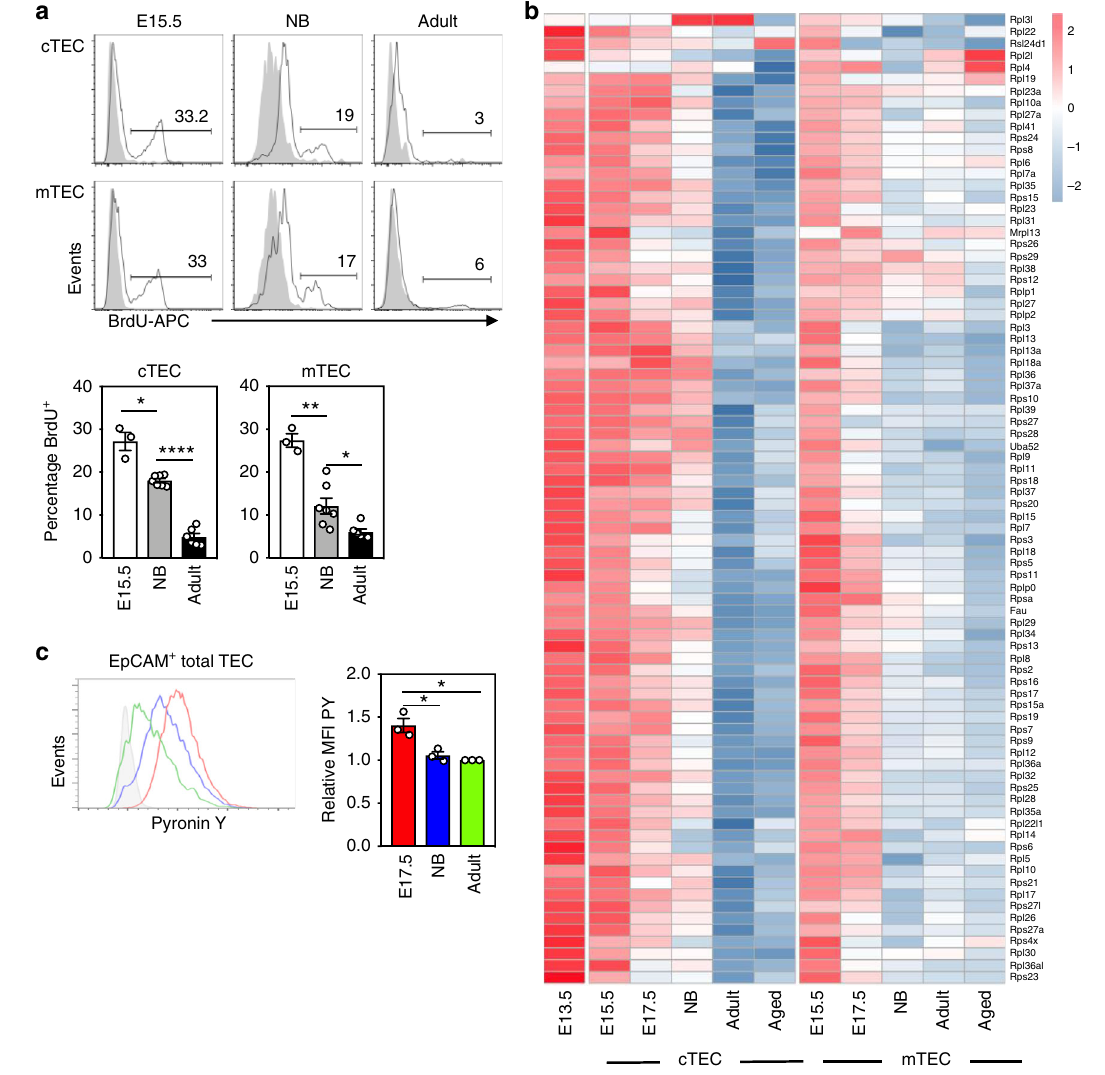
Fig. 2 TEC have reduced rates of proliferation and ribosomal biogenesis with age. a Representative fl ow plots of the frequency of BrdU + cells in cTEC (CD45 − EpCAM + Ly51 + UEA − ) (above) and mTEC (CD45 − EpCAM + Ly51 − UEA + ) (below) displayed as histograms (black line) overlaid on the negative control (gray bar). Bar graphs represent the frequencies of BrdU + cTEC and mTEC populations. b A row normalized heatmap of expression of KEGG ribosomal genes at indicated ages, where each column represents an average of a minimum of three biological replicates. c Representative fl ow plot of Pyronin Y staining on DAPI − CD45 − EpCAM + total TEC from indicated timepoints, overlaid as a histogram, where gray fi lled histogram is RNAse treated adult cells. Bar graph represents the MFI of Pyronin Y at each indicated timepoint, relative to the Pyronin Y MFI of the adult sample which is set to 1 and so has no error bar. All bar graphs show mean ± SEM for a minimum n = 3 mice per age. A two-tailed unpaired Student ’ s t test was performed to determine signi fi cance. * p < 0.05, ** p < 0.01, **** p < 0.0001. The source data underlying ( a , c ), are provided as a Source Data fi